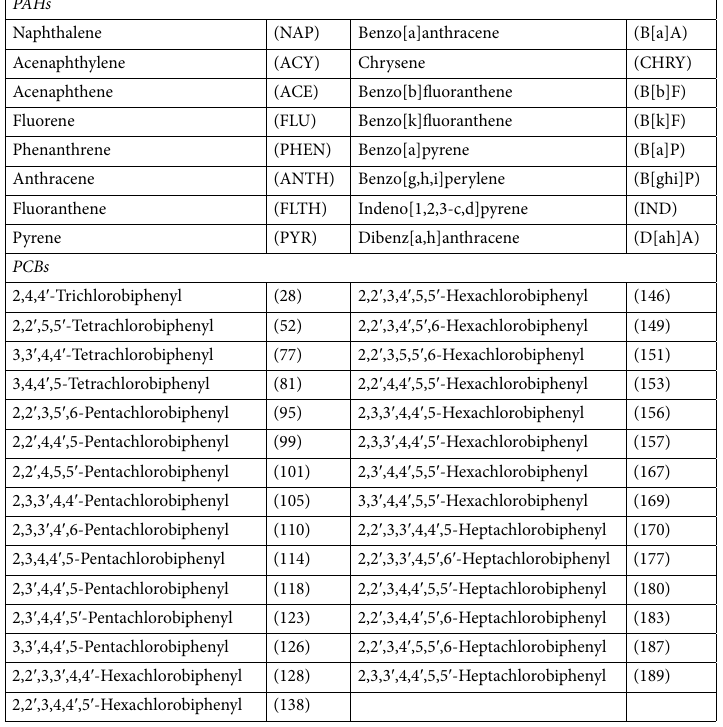
Table 2. List of polycyclic aromatic hydrocarbons (PAHs) and polychlorinated biphenyls (PCBs) investigated in the present study. PAH acronyms and PCB BZ congener numbers are reported in brackets.